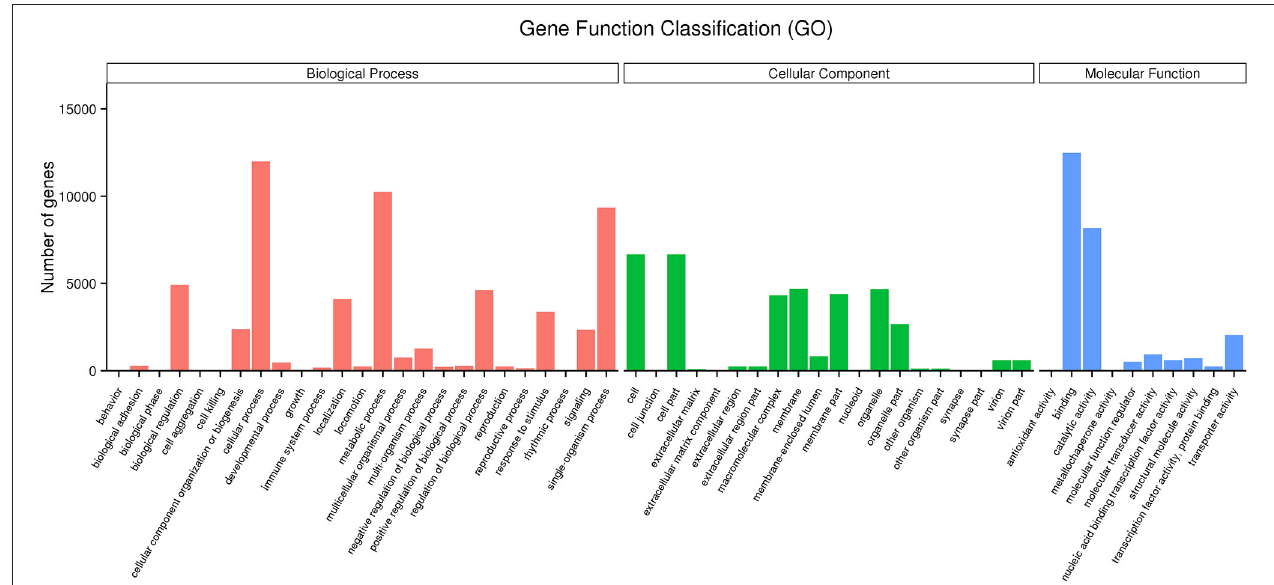
FIGURE 2 | Functional annotation of Aphidius gifuensis transcripts based on gene ontology (GO)